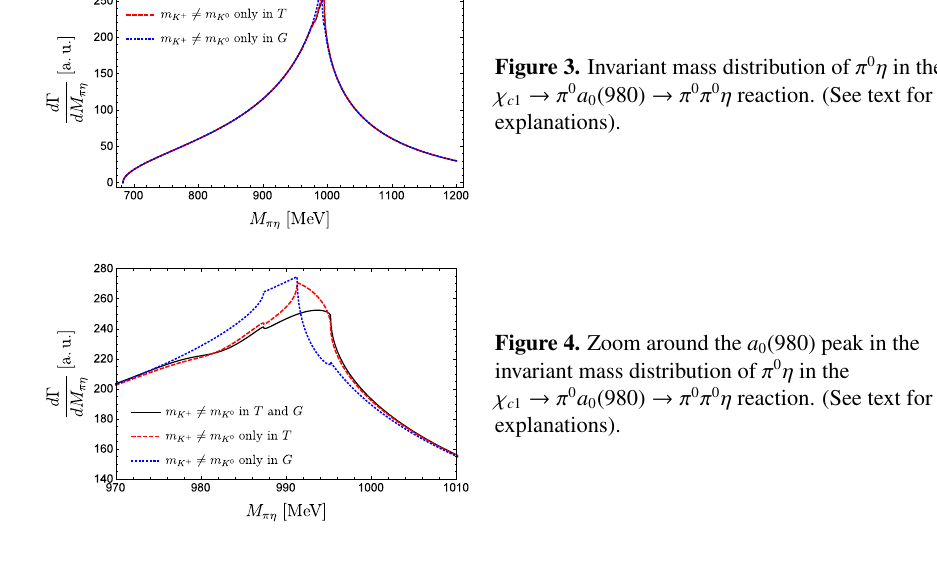
Figure 3. Invariant mass distribution of π 0 η in the χ explanations).